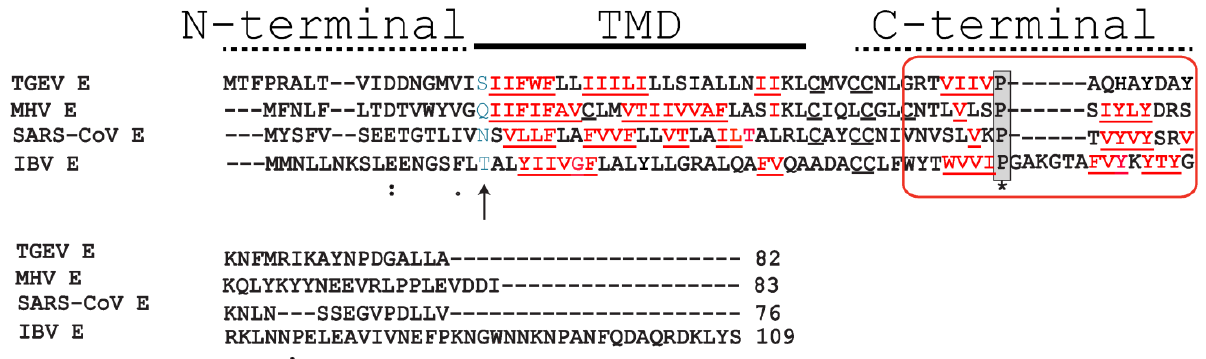
Figure 1. Alignment of representative CoV E proteins. Sequences of E proteins in α-, β- and γ-coronaviruses: TGEV (transmissible gastroenteritis virus) (α), MHV (murine hepatitis virus) and SARS (β), and IBV (γ), with TM domain (TMD) indicated. The fully conserved Proline in the C-terminal domain (highlighted grey) is flanked by predicted β-sheet structure at both sides, forming a hypothetical β-coil-β motif (BCBM) (red square). Polar residues that may be critical for channel activity are shown in blue (arrow). Helix-destabilizing residues in TMD and BCBM are highlighted red, bold and underlined.